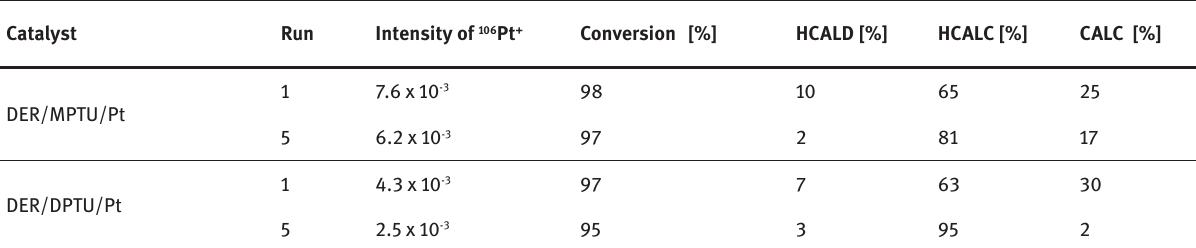
Table 2: The hydrogenation of cinnamaldehyde over the DER/MPTU/Pt and DER/DPTU/Pt.